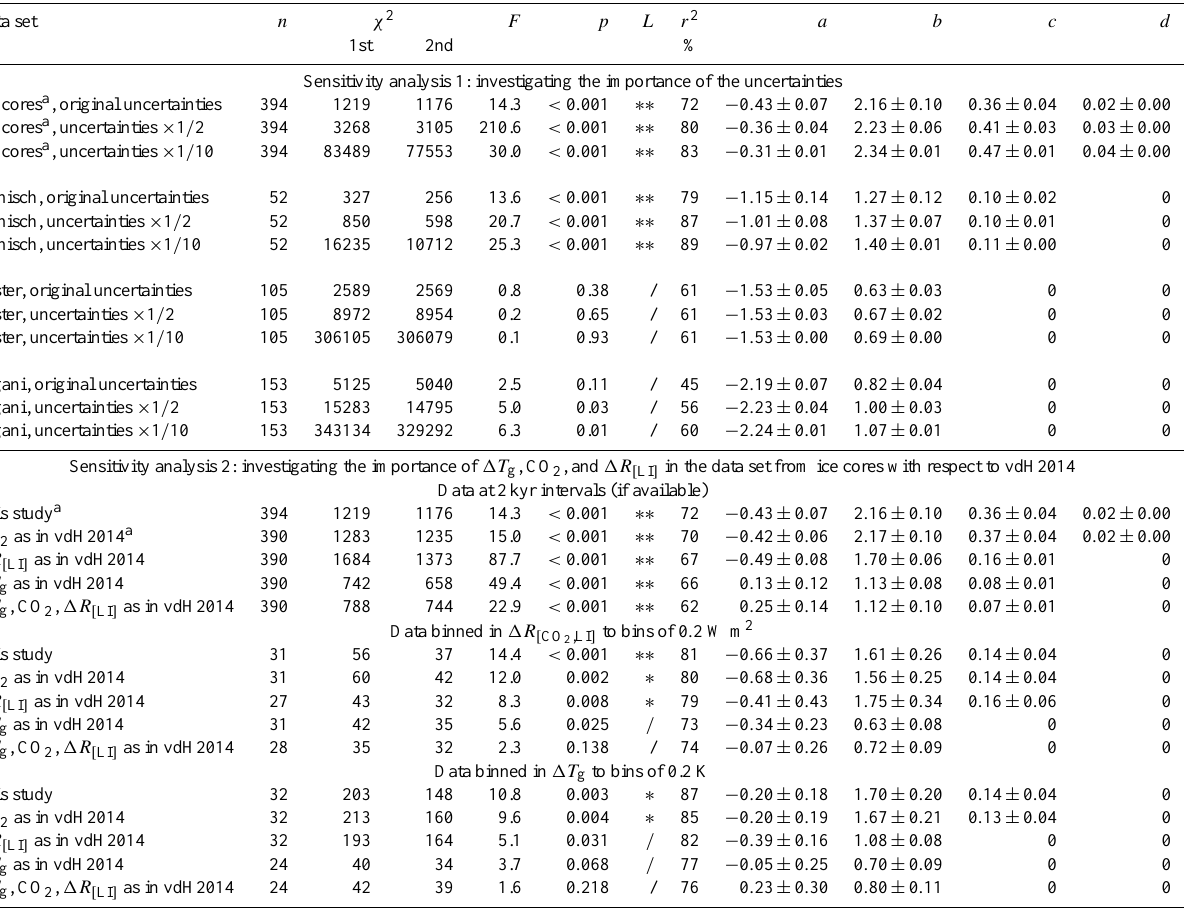
Table 2. Sensitivity analyses: (1) investigating the importance of the uncertainties on the regression results by artificially reducing both σ (cid:49)T and σ (cid:49)R by a factor of 2 or 10; (2) investigating the importance of the three variables (cid:49)T g , CO 2 , and (cid:49)R [ LI ] with respect to the previous analysis of the ice-core-based CO 2 data of von der Heydt et al. (2014) (cited here as vdH2014). Here, all data are resampled to 2kyr, while in vdH2014 data are resampled to 100yrs and binned in (cid:49)T g before any regression analysis. The coefficients a, b, c, and d describe the linear or higher-order polynomial that best fits the data ( F test statistics based on 5000 Monte Carlo-generated realizations of the scattered (cid:49)T g – (cid:49)R [ CO data). The data are randomly picked from the entire Gaussian distribution described by the 1 σ of the given uncertainties in 2 ,LI ] both (cid:49)T g and (cid:49)R [ CO . The parameter values of fitted polynomials are given as mean ± 1 σ uncertainty from the different Monte 2 ,LI ]